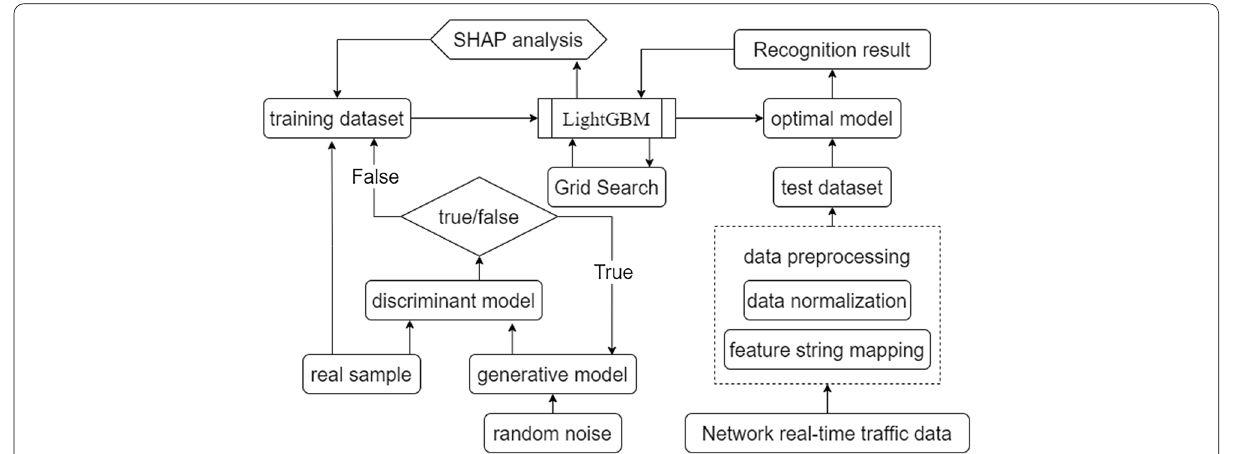
Fig. 2 Network intrusion intelligent detection model construction